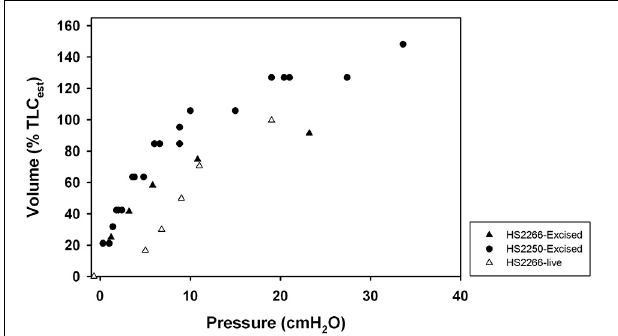
FIGURE 5 | Relationship between transpulmonary (airway pressure minus esophageal pressure) and inspired volume expressed as a percent of estimated total lung capacity (TLC = 0.135 × Mb ∧ 0.92, Kooyman, 1973; Fahlman et al., 2011) for an excised lung and live harbor seal ( Phoca vitulina ). Triangle-HS2266;